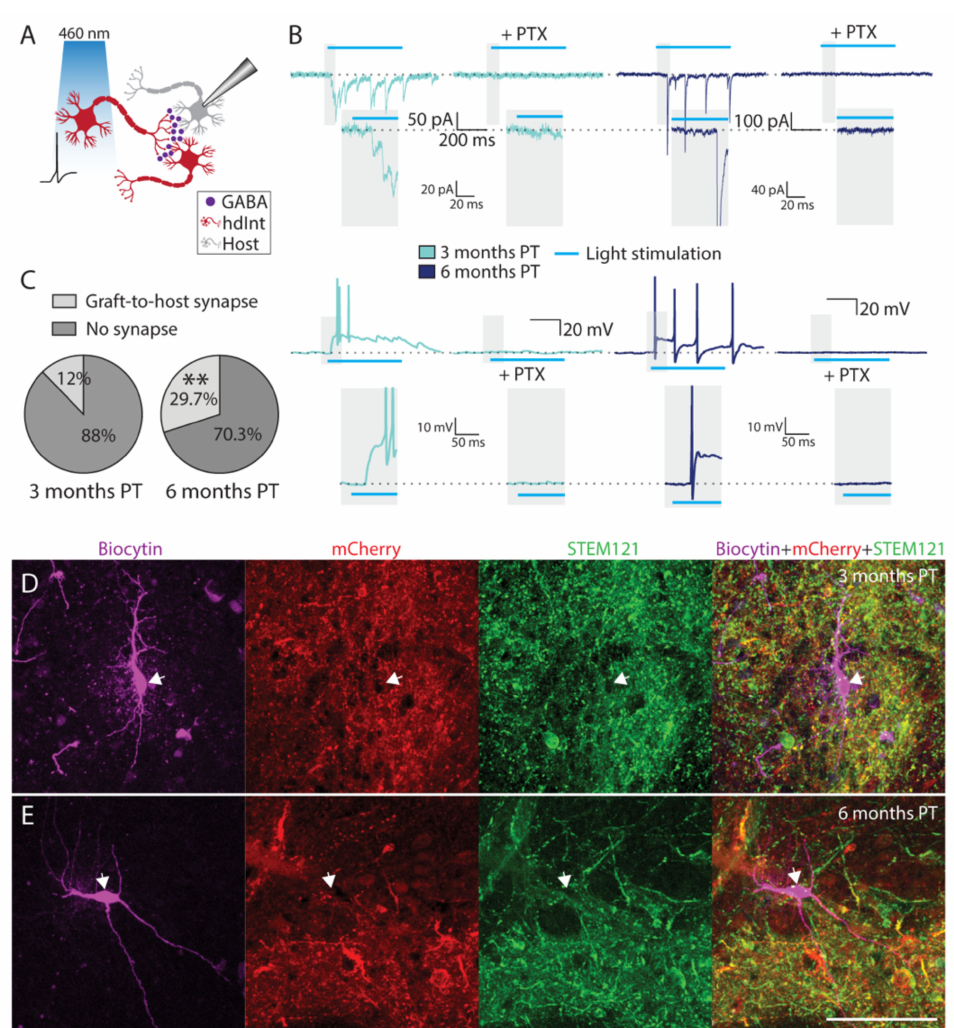
Figure 5. Graft-to-host synaptic connectivity. ( A ) Cartoon representing a recording from a host neuron receiving inhibitory synapses from a grafted hdInt (a graft-to-host synapse) activated by blue light. ( B ) Representative traces from recorded host neurons in voltage- and current-clamp mode